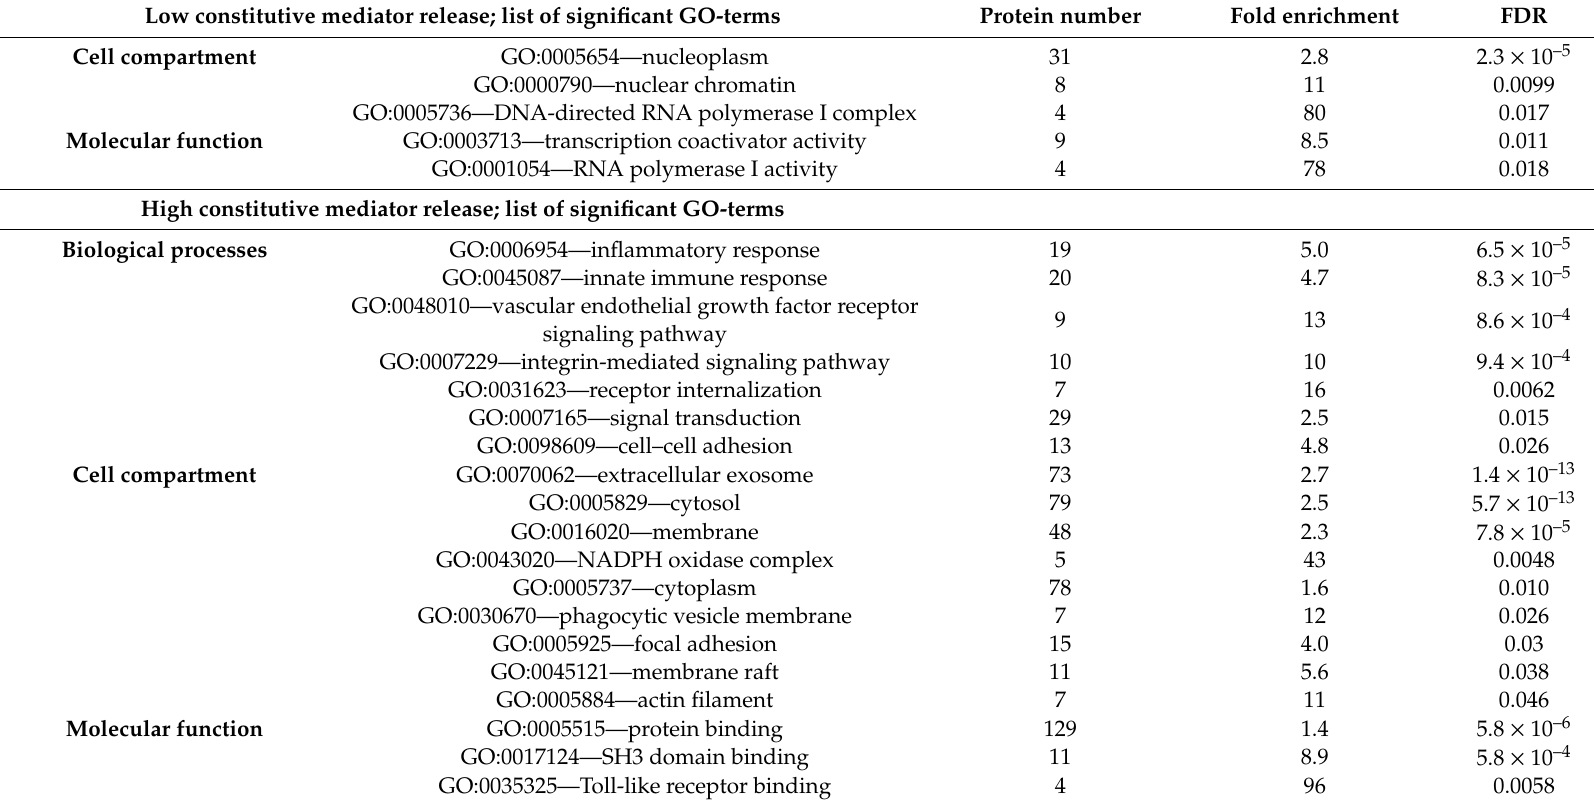
Table 4. Significant GO-terms (i.e., FDR < 0.05) for proteins showing significantly increased levels in AML patients with intermediate / low and high constitutive mediator